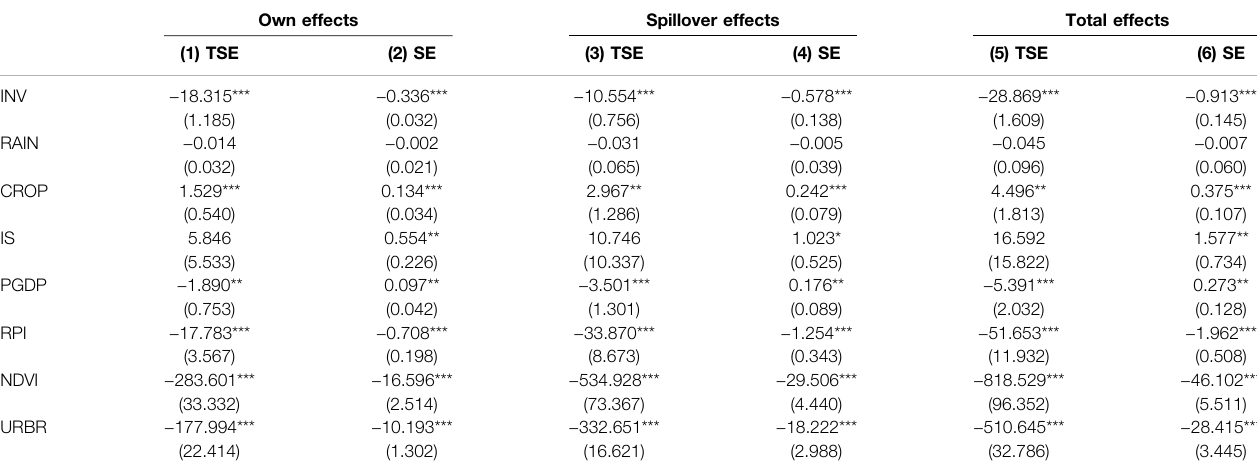
TABLE 6 | Estimation results of different effects in the